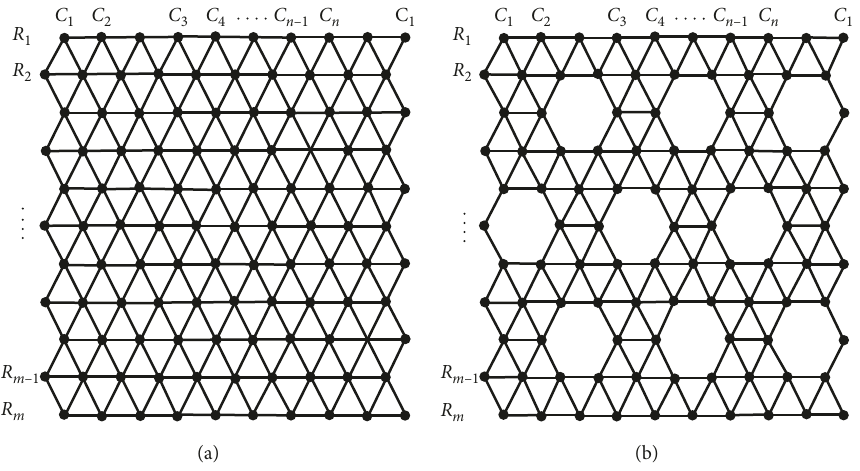
Figure 2: (a) A 2D sheet of boron triangular nanotube BT [ m,n ] . (b) A 2D sheet of boron- α nanotube BA [ m,n ] .